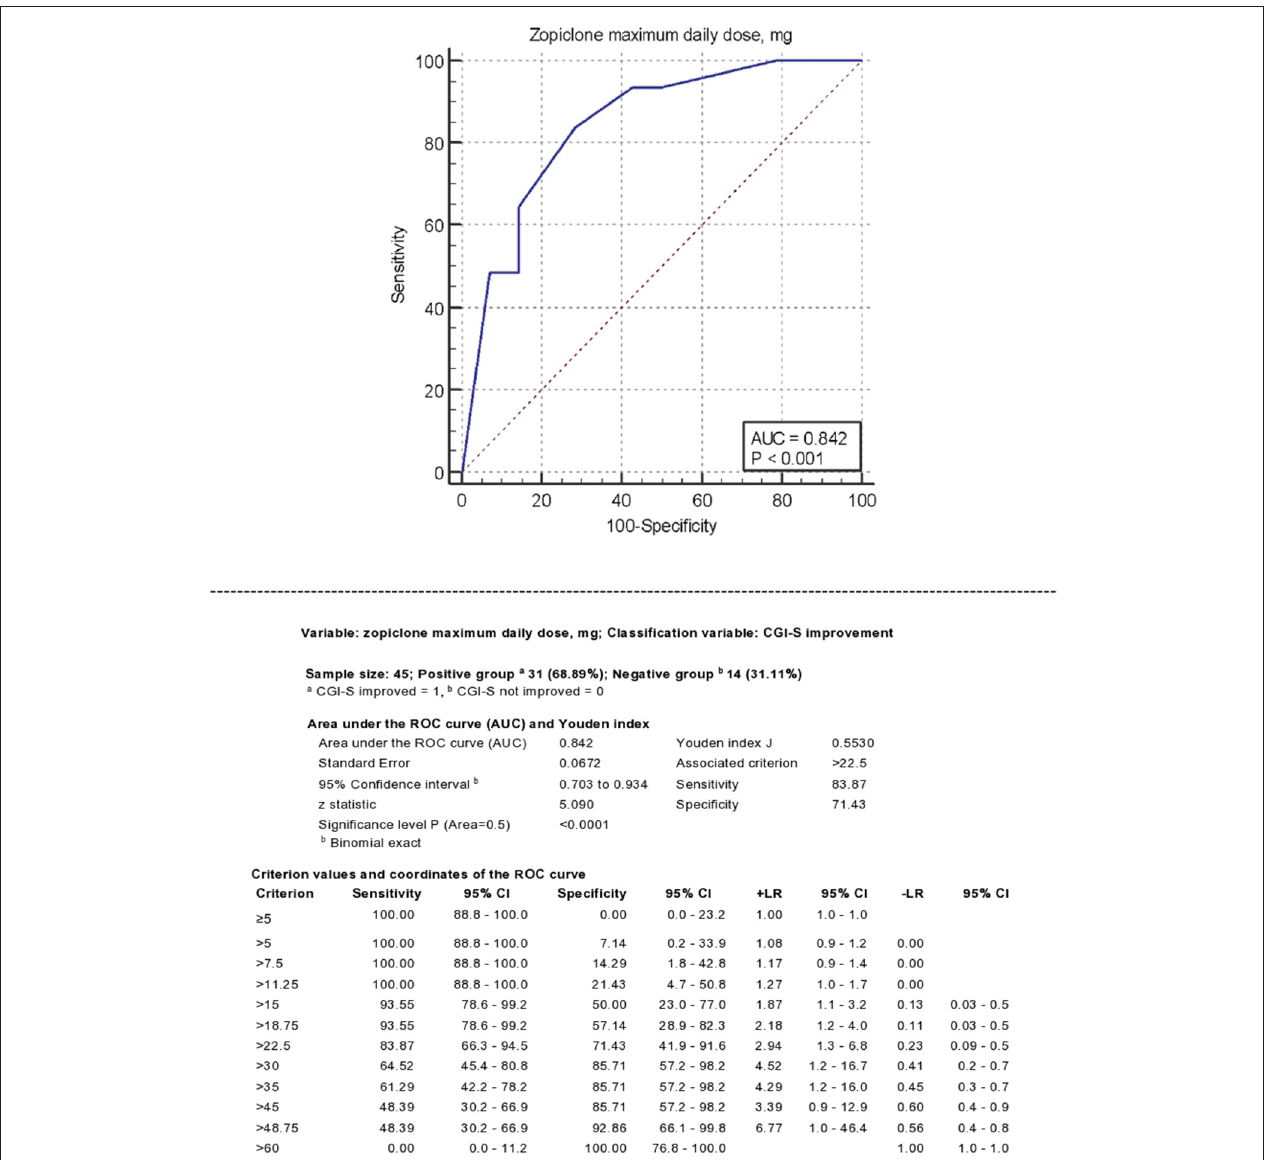
FIGURE 2 | Receiver operating characteristics (ROC) analysis. Classificatory variable: CGI-S